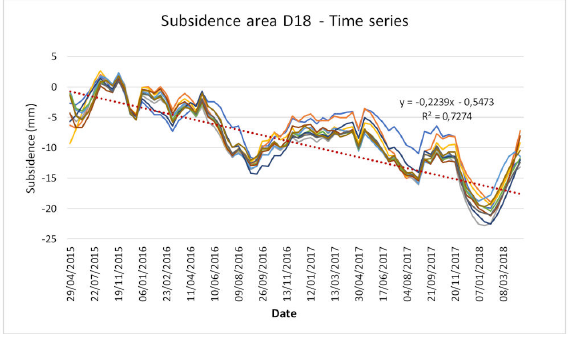
Figure 6. Subsidence area time series of the D18